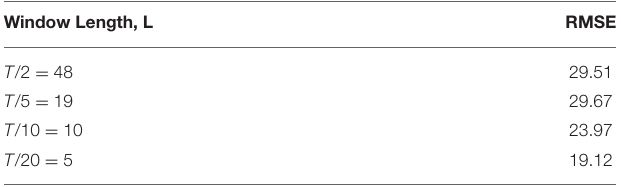
TABLE 1 | Comparison of Singular Spectrum Analysis Prediction Performance for Several Window Length ( L ). Window Length,